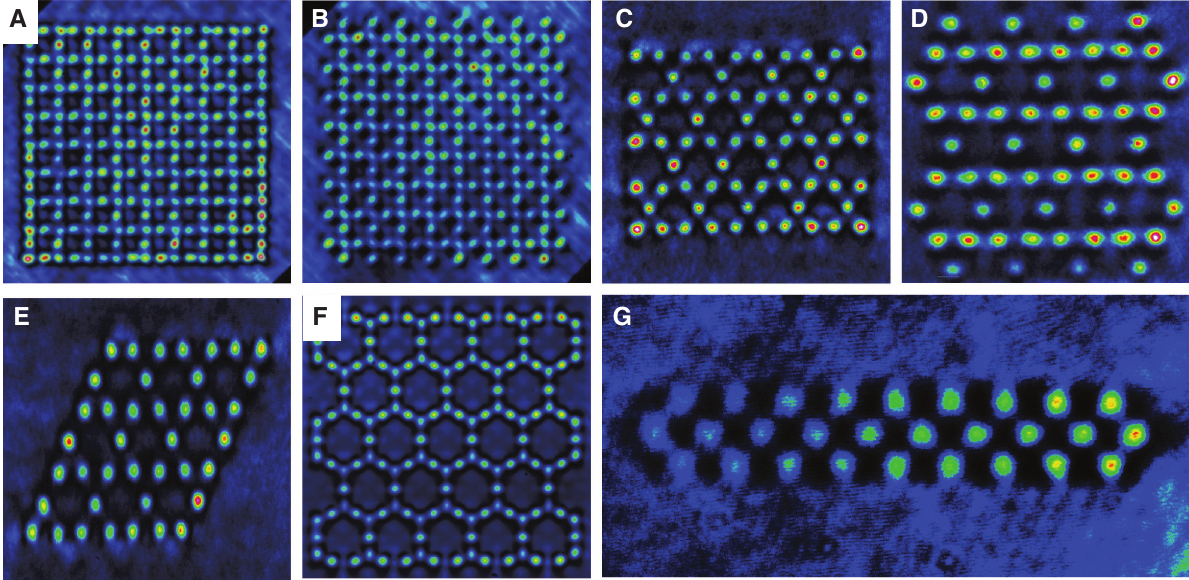
Figure 3: Typical examples of the flat-band photonic lattices created in a nonlinear bulk crystal with the cw-laser-writing technique. (A, B) Lieb [81] lattices with different boundary terminations, (C–E) Kagome lattices with different boundary terminations [86], (F) a super- honeycomb lattice [85], and (G) a “driven” rhombic lattice with an index gradient